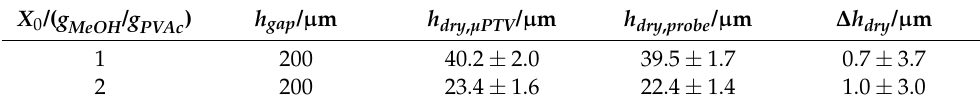
Figure 5. Comparison of drying curves for poly(vinyl acetate)-methanol films at T substrate = 20 ◦ C and ambient drying conditions. The filled areas denote experimental results from 3D- µ PTV measurements accounting for refractive index uncertainty in the evaluation. The true drying curves would align with the lower bounds of the grey areas at t = 0 s and with the upper bounds for solvent depleted films. ( a ) X 0 = 1 g MeOH / g PVAc , h gap = 100 and 200 µ m. ( b ) X 0 = 1.5 g MeOH / g PVAc , h gap = 50, 100, 150, and 200 µ m. Table 1. Comparison of dry-film thicknesses measured using 3D- µ PTV and physical